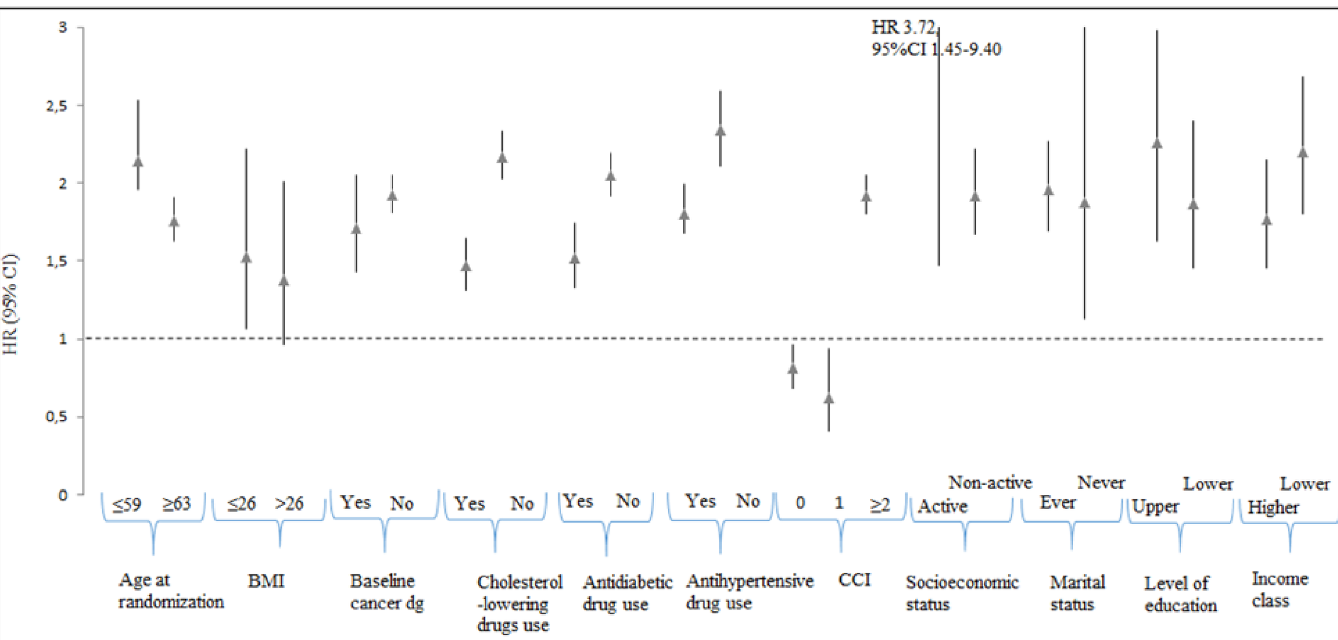
Fig 1. Overall cancer cancer mortality by NSAID current use versus non-use stratified by patient characteristics in the Finnish Prostate Cancer Screening Trial.